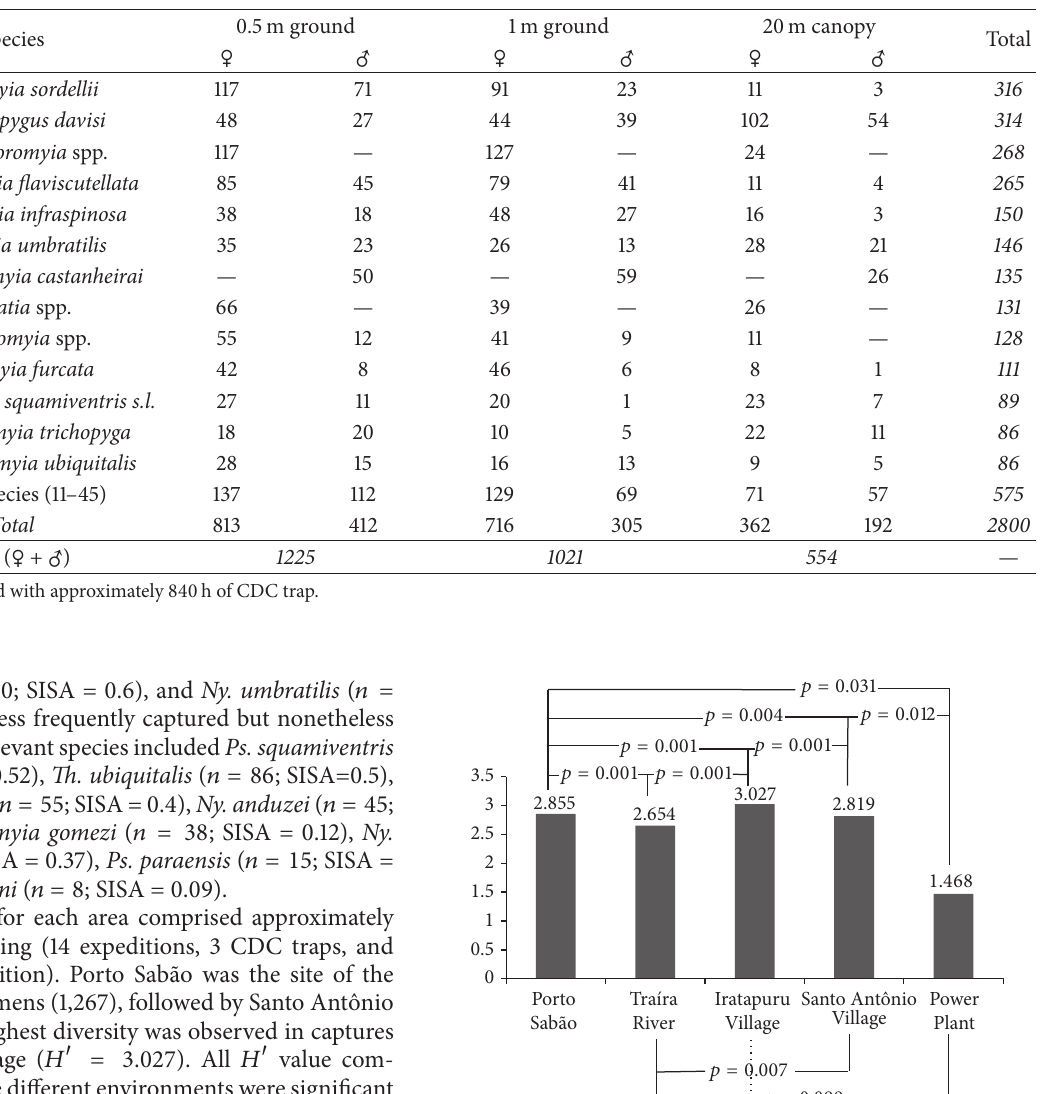
Table 2: Vertical stratification of Phebotomine species composition of Santo Antˆonio do Jari hydroelectric system impacted area (Amap´a State, Amazonian Brazil) on the basis of five surveyed locations (2012–2015).